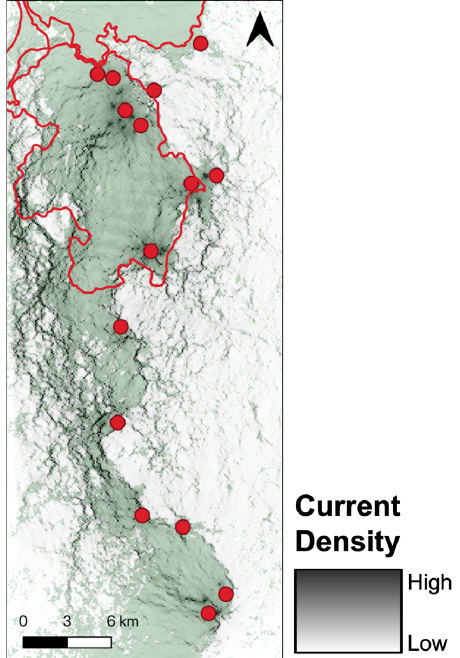
Figure 9. Cumulative resistance among individuals for optimized canopy height created using Circuitscape v4.0.5 (https://circuitscape.org; accessed on 22 January 2019). Darker greys indicate areas of higher conductance (i.e., low resistance, high dispersal); lighter greys indicate areas of higher resistance (i.e., low conductance, low dispersal). Cumulative resistance is overlayed on 2016 forest cover and red circles represent the 15 sampling localities throughout the